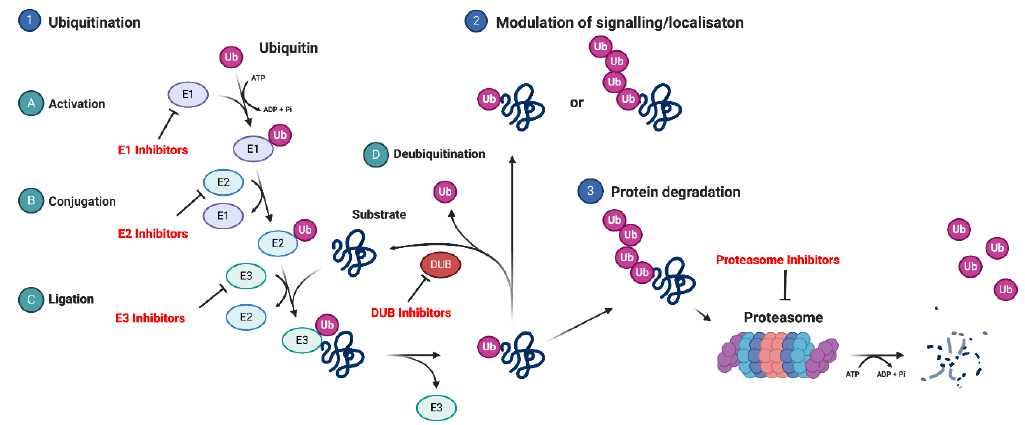
Figure 3. The ubiquitin enzymatic cascade and the ubiquitin-proteasome system (USP). (1) A diagram of the ubiquitin enzymatic cascade. Ubiquitin is added to protein substrates via the E1-E2-E3 enzymatic cascade; (A) E1 activating enzymes, which catalyze the addition of ubiquitin to E1 enzymes is ATP-dependent [39]; (B) E2 conjugating enzymes; (C) E3 ligases, which catalyze the addition of ubiquitin to protein substrates and (D) deubiquitinases, which catalyze the removal of ubiquitin from protein substrates. The addition of ubiquitin to protein substrates can have serval consequences, including (2) the modulation of signal transduction or protein recruitment and localization or (3) proteasomal degradation, which requires ATP. Highlighted in red are components of the ubiquitin system that have been targeted with small molecule inhibitors and are discussed in this review.